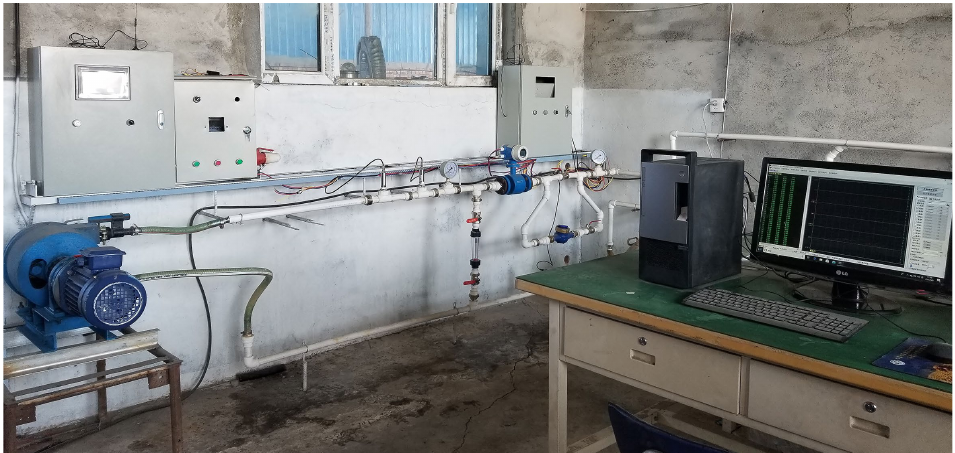
Figure 15. Fertilizer pH adjustment and detection experimental platform.